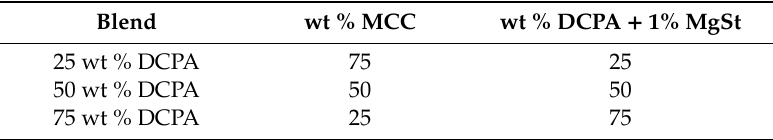
Table 2. Composition of the blends of MCC and DCPA processed on the XL